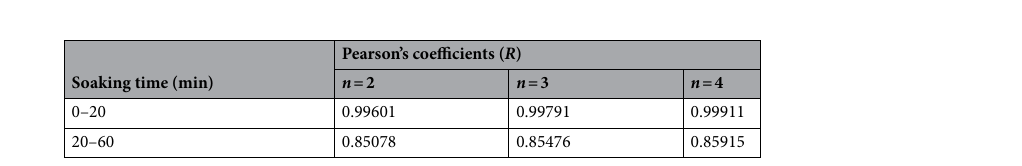
Figure 8. Plot of mean grain size ( a ) squared, ( b ) cubed and ( c ) quadruplicated as a function of holding time for Al–Fe–Cu alloy reheated at 630 °C, ( d ) relationship between quartic power of equivalent diameter and holding time for the alloy in various temperatures, lines represent the best linear fitted to the data. R is Pearson’s coefficient.